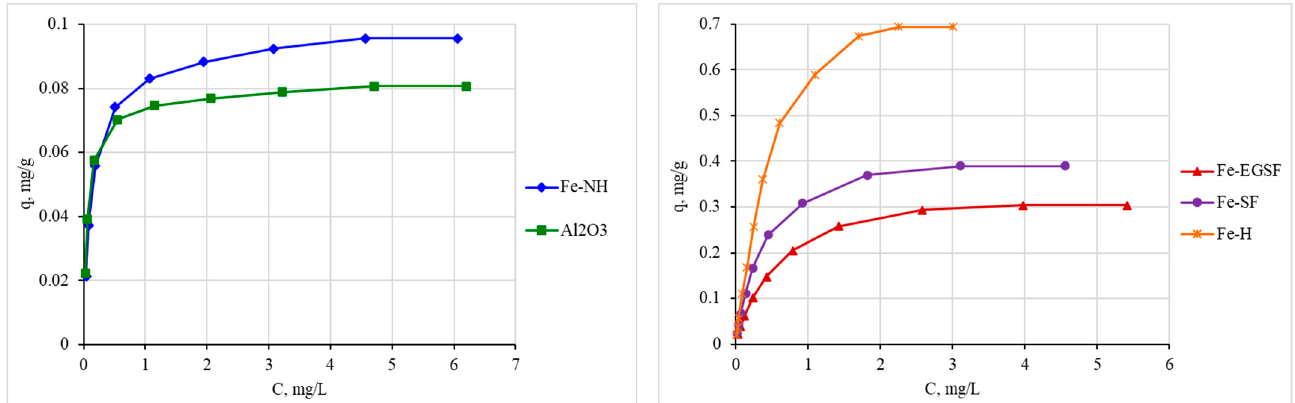
Figure 3. Beryllium sorption isotherms.